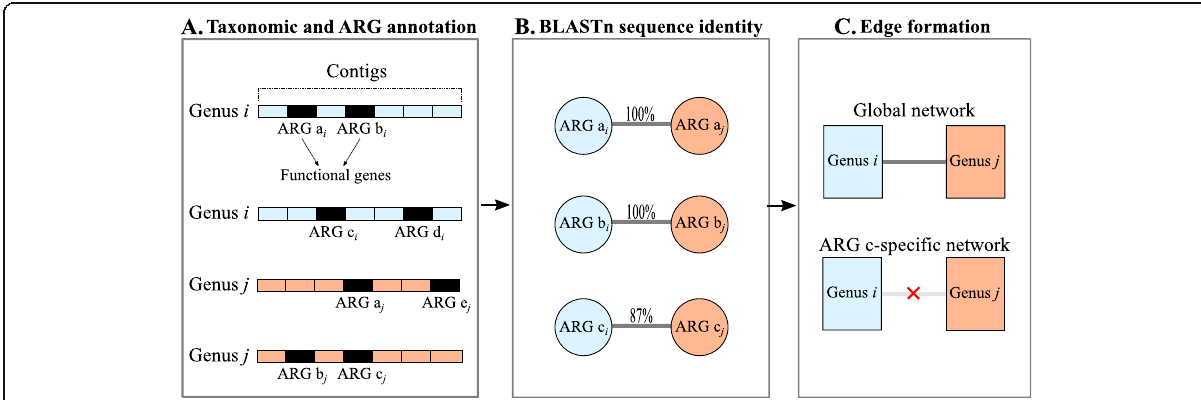
Fig. 7 Construction of ARG-sharing networks based on metagenomes. a Contigs and their functional genes were annotated as bacterial genus and ARGs, respectively. b BLASTn Sequence identity was computed for each pair of functional genes annotated as ARGs. A pair of genes was assumed to represent the same ARG if its BLASTn sequence identity was 100%. c In the global network, genera were connected if their contigs shared ≥ 1 ARG of any type in ≥ 1 sample among those collected from a given animal species, whereas only the ARG of interest was considered in the ARG-specific